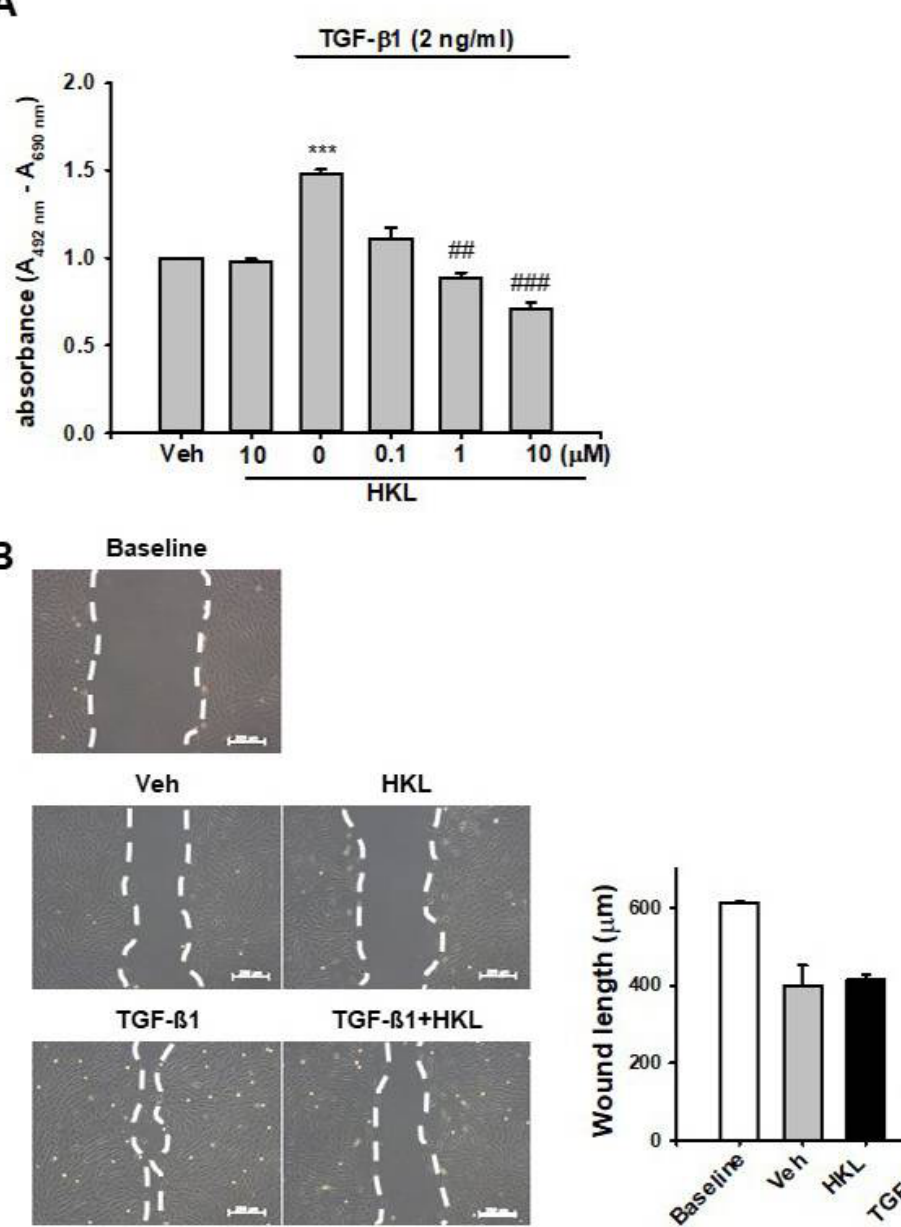
Figure 6. E ff ect of honokiol on TGF- β 1-induced fibroblast proliferation and cell migration in NRK-49F cells ( A ) NRK-49F cells were treated with vehicle (Veh) or transforming growth factor- β 1 (TGF- β 1, 2 ng / mL), with or without honokiol (HKL) at indicated doses (0.1, 1, and 10 µ M). After 24 h of treatment, cell proliferation was measured by XTT assay. Data are expressed as mean ± SD for three independent experiments in triplicates. *** p < 0.001 versus Veh or HKL; ## p < 0.01, ### p < 0.001 versus TGF- β 1 (2 ng / mL). ( B ) Representative phase-contrast images for NRK-49F cells after wound healing assay. The phase-contrast images of migration of NRK-49F cells into a scratch area were obtained after treatment with either Veh or TGF- β 1 (2 ng / mL), with or without HKL (10 µ M), at 0 or 24 h after wounding. The bar graph shows the average length by which the gap between the NRK-49F cells closed over 0 or 24 h after treatment with Veh, TGF- β 1, and / or HKL. *** p < 0.001 versus Veh or HKL; ### p < 0.001 versus TGF- β 1. Bar = 200 µ m. Veh, vehicle; HKL, honokiol; TGF- β 1, transforming growth factor- β1.